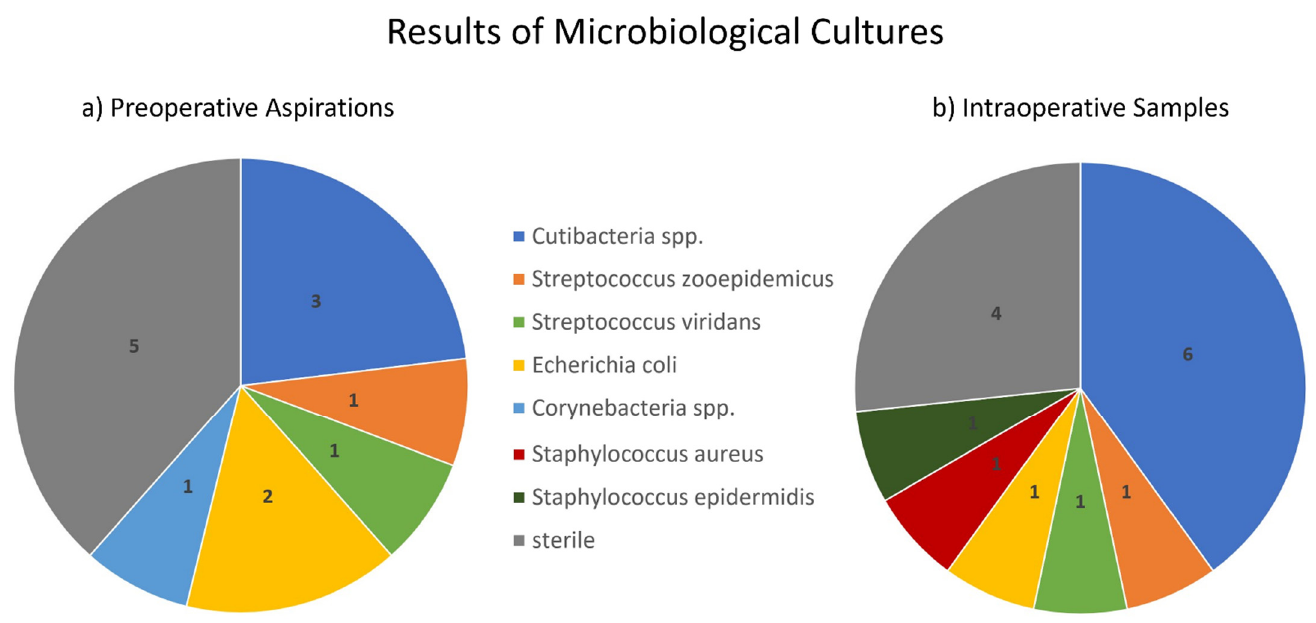
Figure 1. Results of microbiological cultures from ( a ) preoperative aspiration and ( b ) intraoperative samples. Numbers in the diagram represent case numbers. The percentage of sterile samples decreased from 38% in PA to 27% in intraoperative cultures. The percentage of cutibacteria species (spp.) increased from 23% in PA to 40% in intraoperative cultures.